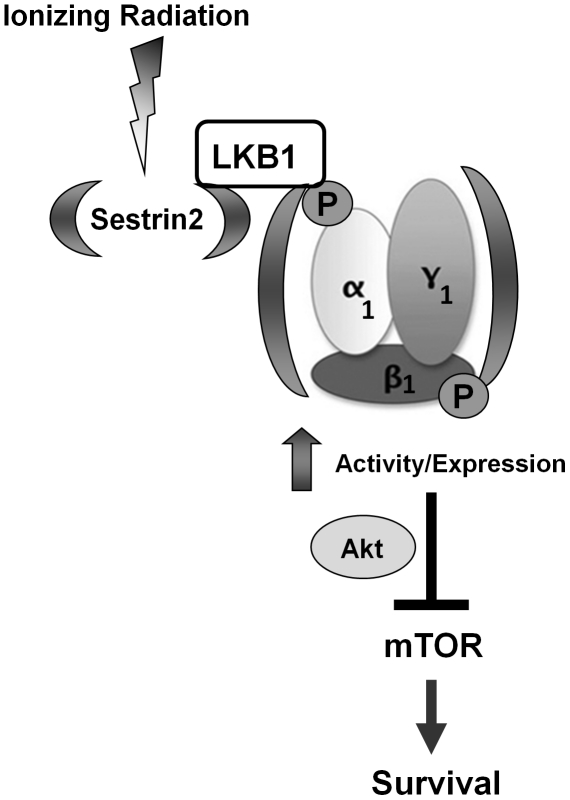
A proposed model of SESN2-mediated AMPK regulation in response to IR in MCF7 cells.In response to genotoxic stress (IR), SESN2 is enhanced and leads to the formation of an active LKB1/AMPKα1β1γ1 complex. SESN2 may stabilize the AMPK complex, or transcriptionally regulate AMPK and enhance its expression. Both SESN2 and AMPK may then coordinate mTOR suppression, which translates into enhanced IR-induced cancer cell killing.